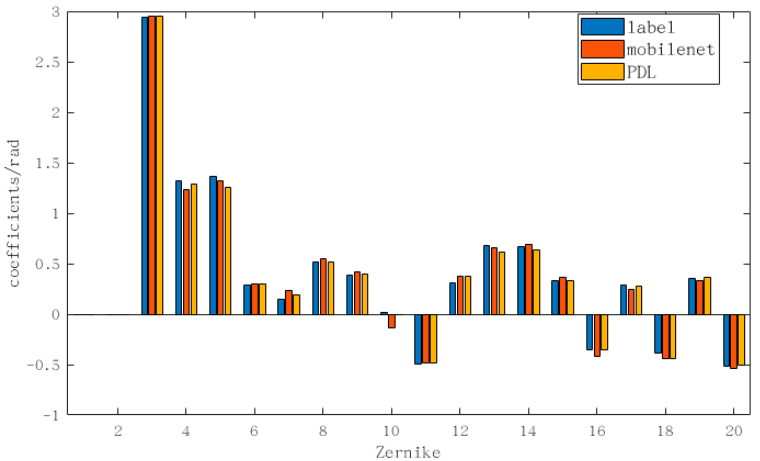
Figure 4. Comparison of the Zernike coefficient between original distributions, supervised learning, and self-supervised learning.